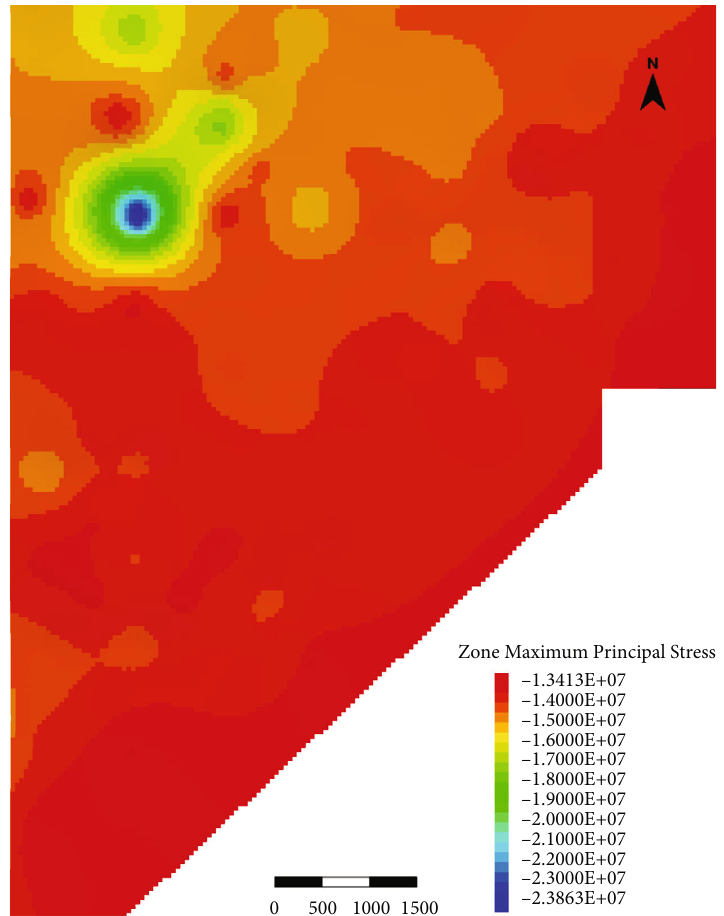
Figure 4: Maximum principal stress distribution of key strata after the initial equilibrium